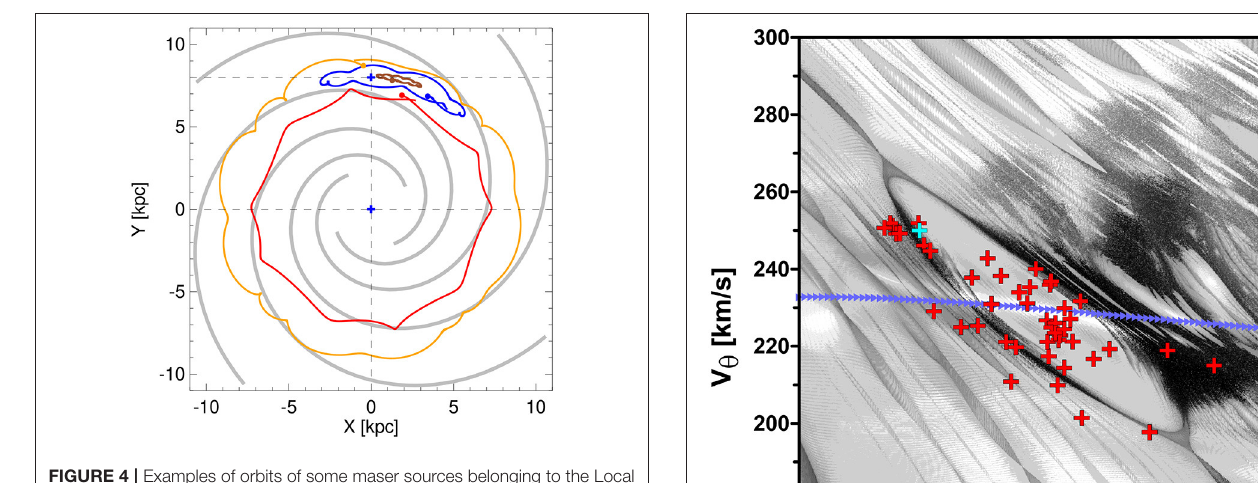
FIGURE 4 | Examples of orbits of some maser sources belonging to the Local Arm. The blue and brown orbits illustrate librating–type orbits in the Lagrange points, which evolve around the equilibrium center of the local corotation zone. The red and orange orbits are of the circulating type, in the prograde and retrograde senses, respectively. The filled dots indicate the current positions of the maser sources. The gray spirals indicate the loci of the spiral arms, and the blue crosses show the positions of the Sun and the Galactic center, as in Figure 2 .